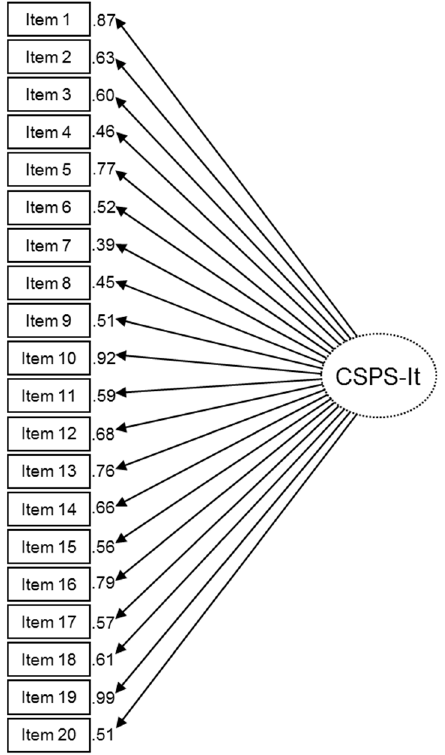
Figure 2. Confirmatory factor analysis (CFA) of the Compliance with Standard Precaution Scale–Italian version (CSPS-It).